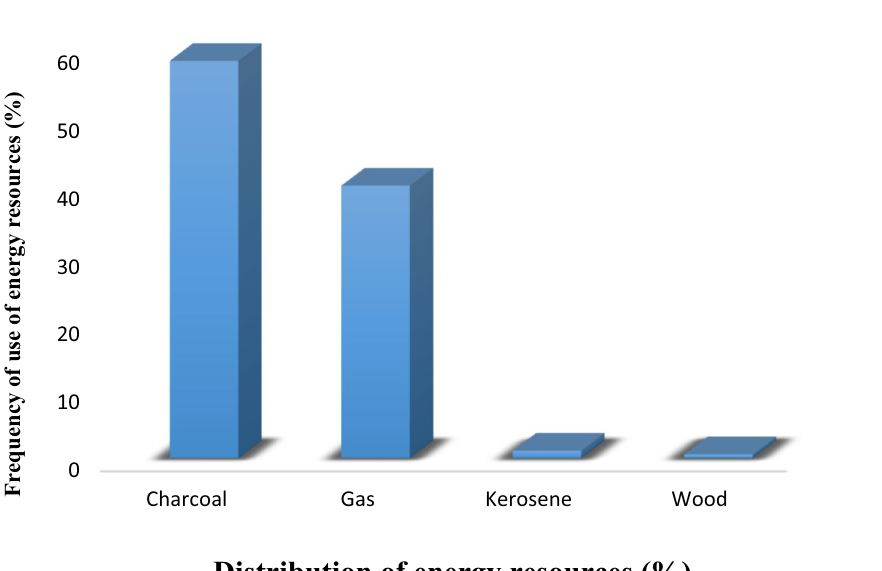
Figure 2. Distribution of energy resources